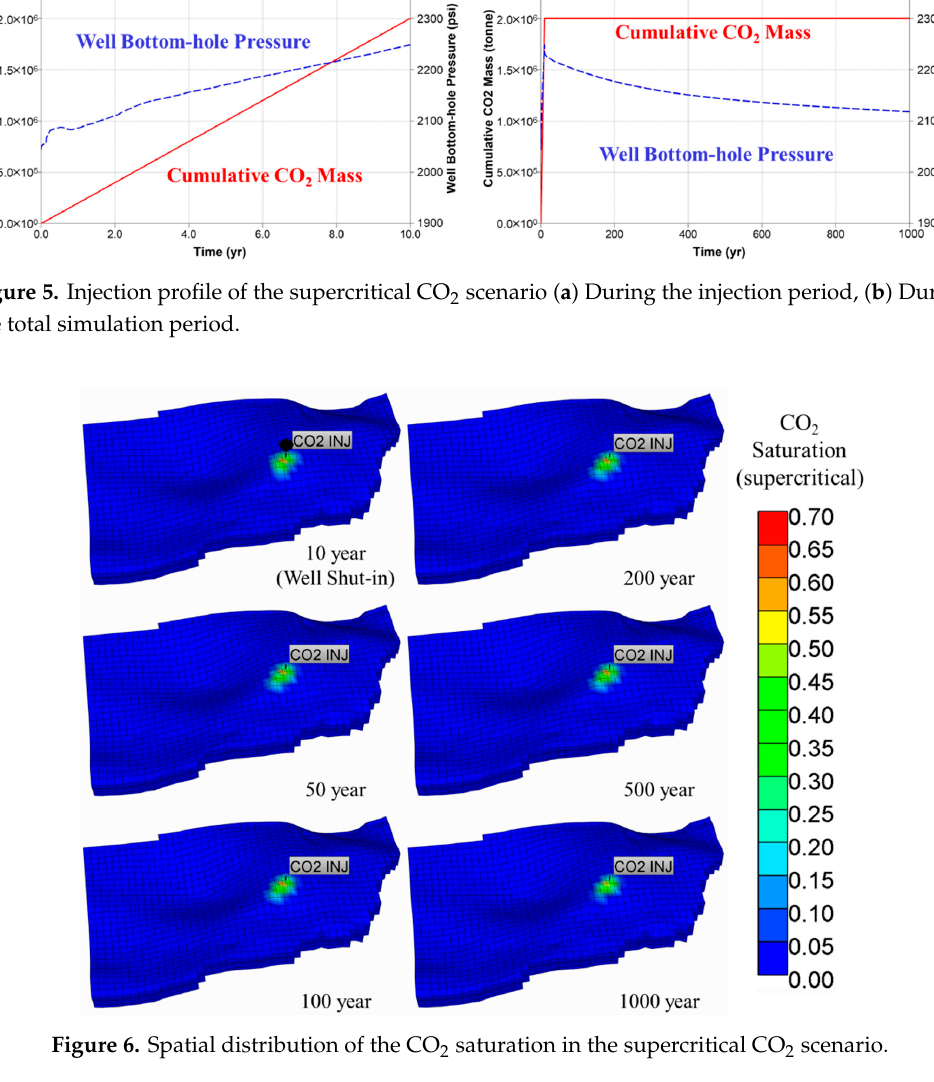
Figure 6. Spatial distribution of the CO 2 saturation in the supercritical CO 2 scenario.